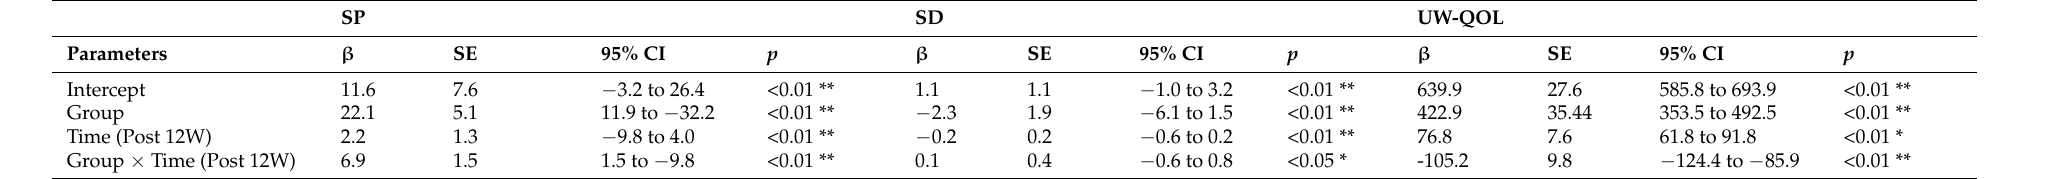
Table 2. The GEE analyses of shoulder pain, shoulder disability, and UW-QOL scores in relation to group and time ( n = 40).